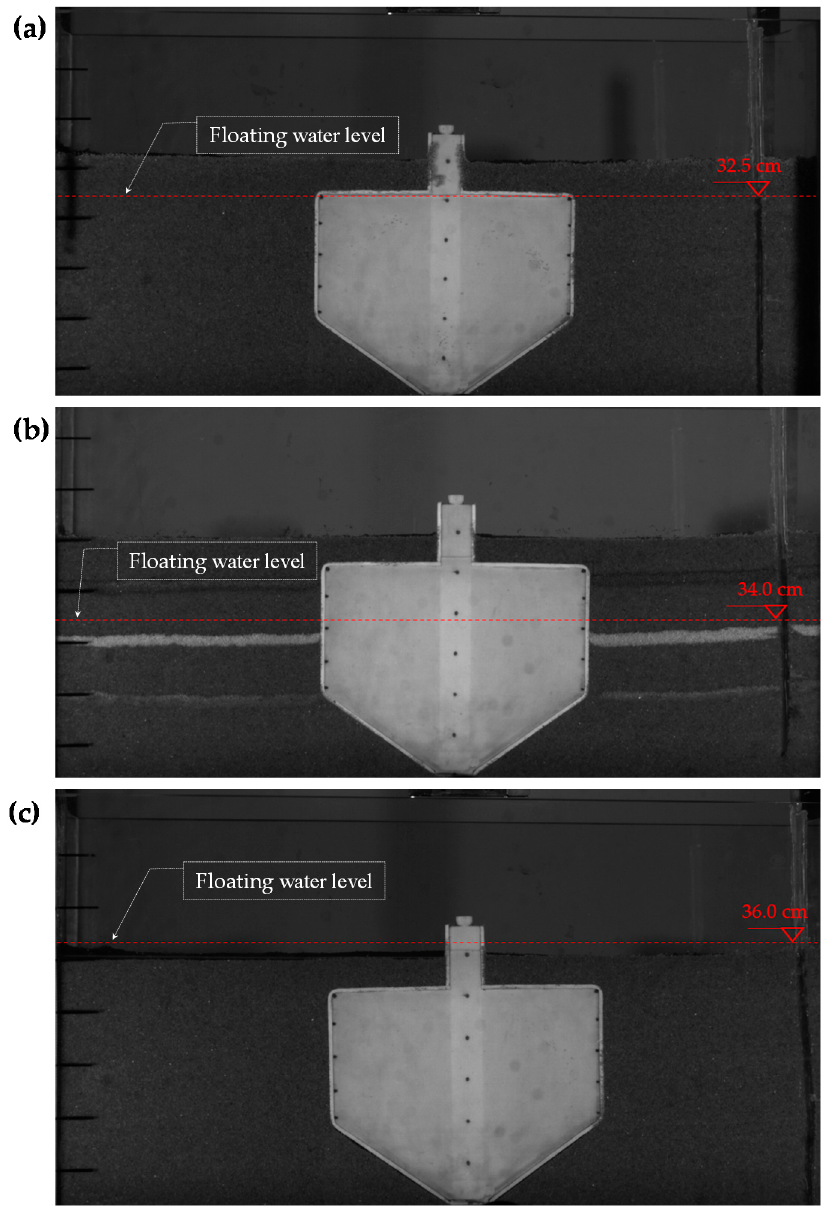
Figure 7. Floating water level for different working conditions: ( a ) in loose sands; ( b ) in medium dense sands; ( c ) in dense sands.